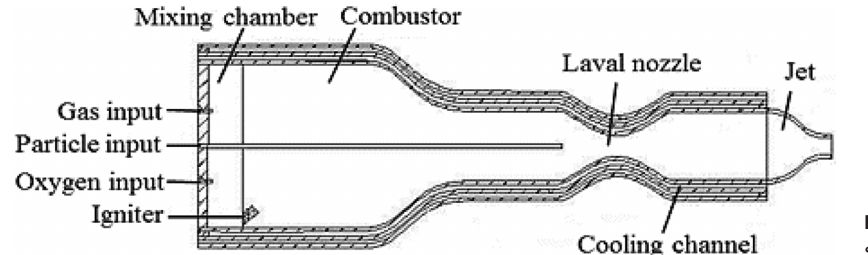
Figure 1: Schematic illustration of spraying